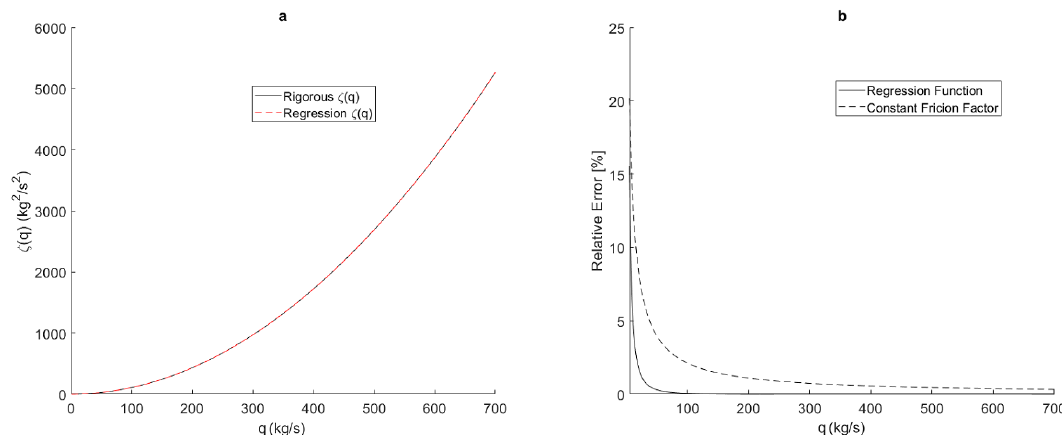
Figure 9. ( a ) Relationship between ζ ( q ) and mass flow rate, and quadratic regression approximation; ( b ) Comparison of error for ζ ( q ) from the quadratic regression and constant friction factor. All for a pipeline with a diameter of 0.9144 m and absolute roughness of 0.05